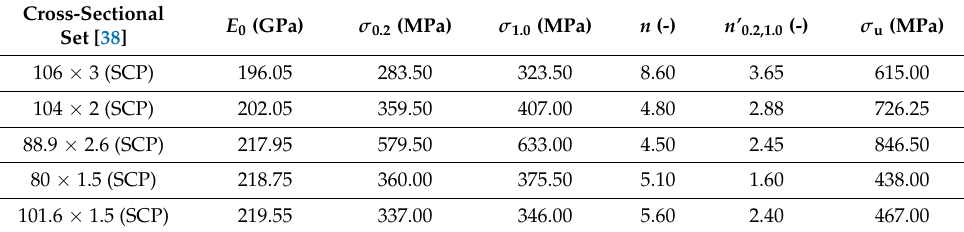
Table 1. Summary of the stub-column material properties (SCP).